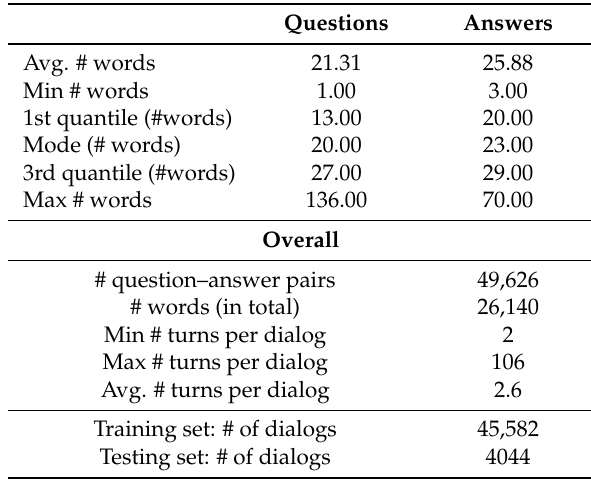
Table 1. Statistics about our dataset. (Reprinted by permission from Springer Nature: Springer Lecture Notes in Computer Science (Hardalov, M.; Koychev, I.; Nakov, P. Towards Automated Customer Support [20]),